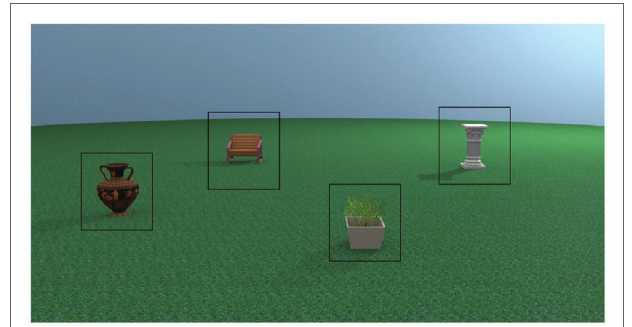
FIGURE 2 | Example region of interest (ROI) placement for one learning stimulus.